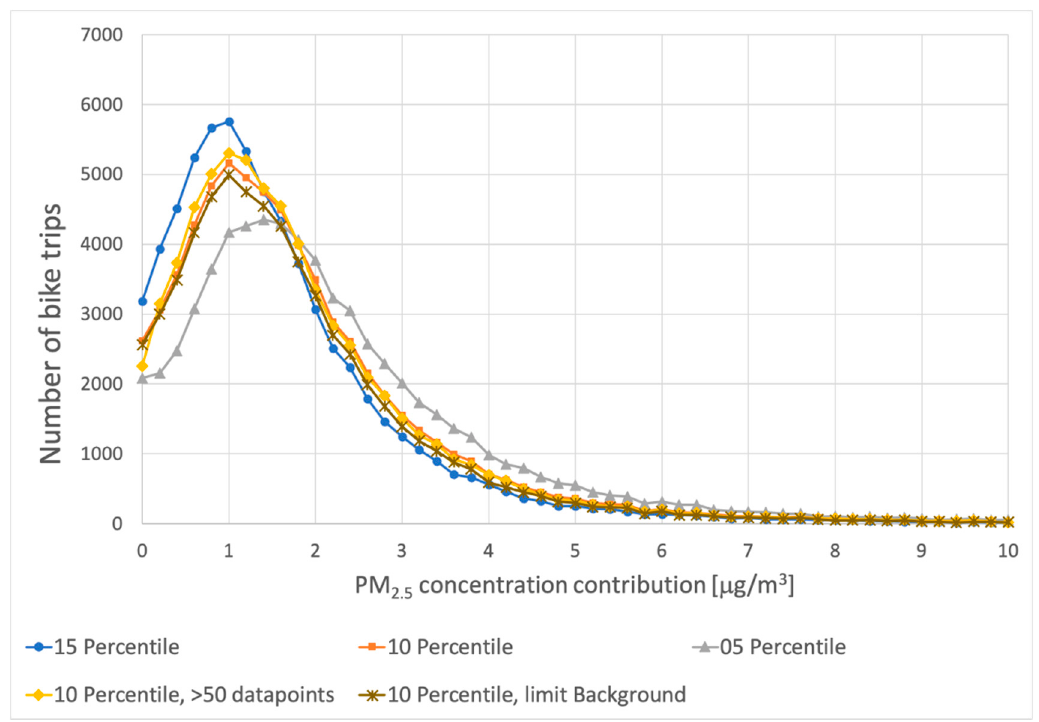
Figure 11. The number of times estimated PM 2.5 contributions due to road traffic were measured by the bicycles, with different percentiles as background concentration. The “05–10–15“percentiles: estimated contributions due to road traffic using the 0.05–0.10–0.15 percentile of bike measurements as an assumed background; “10 Percentile, 50 points”: estimated contributions due to road traffic using the 0.10 percentile of bike measurements as an assumed background and requiring a minimum of 50 datapoints in a bike trip; “10 Percentile, limited”: estimated contributions due to road traffic using the 0.10 percentile of bike measurements as an assumed background and excluding hours with relatively fast changing global background in the province.